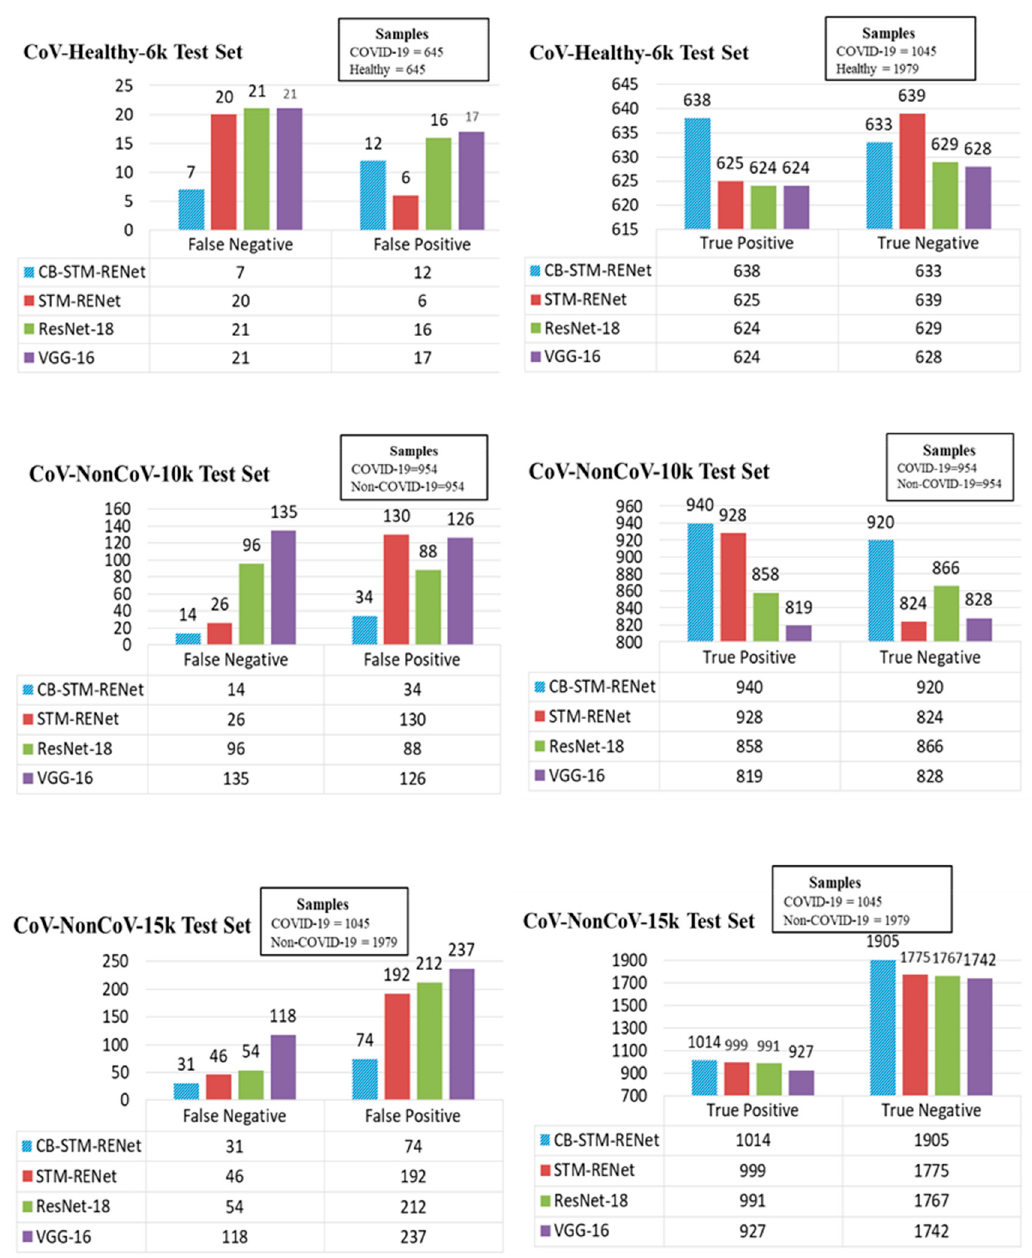
Figure 11. Detection and misclassification rate analysis of the proposed CB-STM-RENet with the existing CNN models.